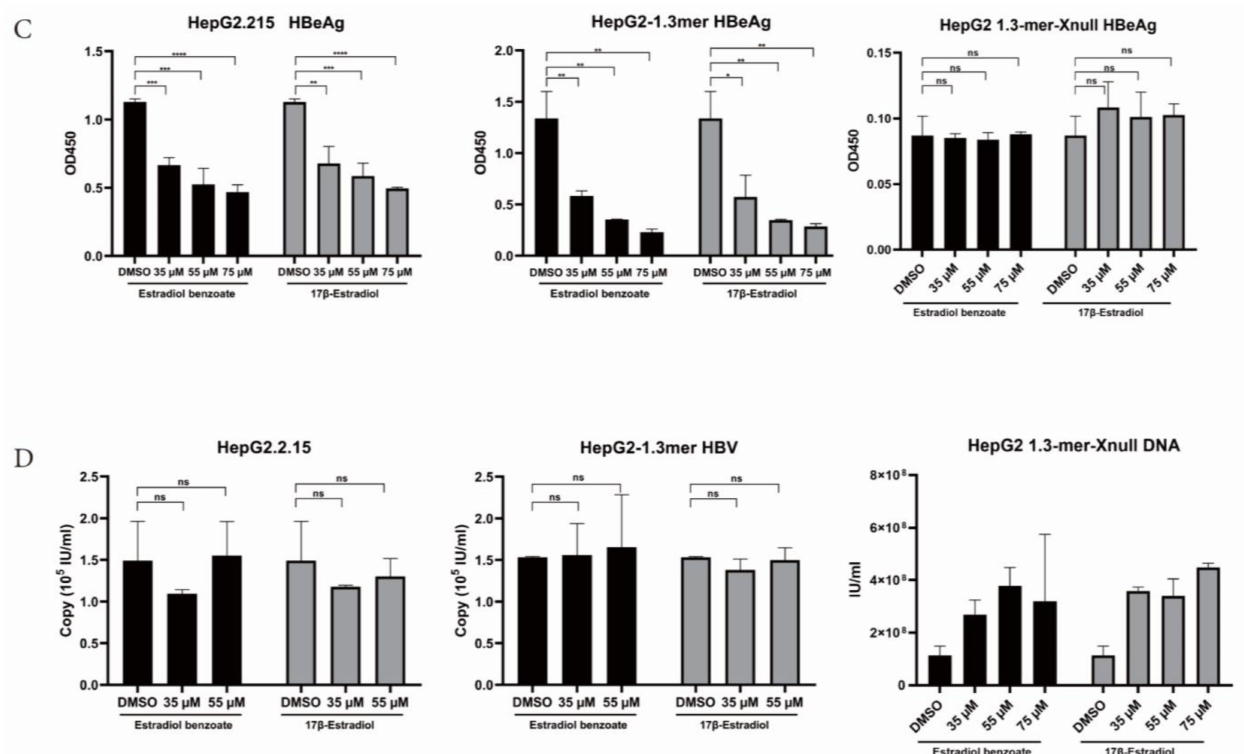
Figure 2. Estradiol benzoate and 17 β -estradiol inhibit HBV transcription and replication. ( A ) Schematic diagram of cell processing and detection. ( B ) ELISA assay of HBsAg levels of estra- diol benzoate– and 17 β -estradiol–treated HepG2.2.15 cells, 1.3mer HBV–transfected HepG2 cells and 1.3mer HBV X-null plasmid transfected HepG2 cells in different concentrations. ( C ) ELISA assay of HBeAg levels of estradiol benzoate– and 17 β -estradiol–treated HepG2.2.15 cells, 1.3mer HBV–transfected HepG2 cells, and 1.3mer HBV X-null plasmid transfected HepG2 cells in different concentrations. ( D ) Quantitative assay of supernatant HBV DNA. DMSO: dimethyl sulfoxide, NS: no significant, * p < 0.05, ** p < 0.01, *** p < 0.001, **** p < 0.0001.